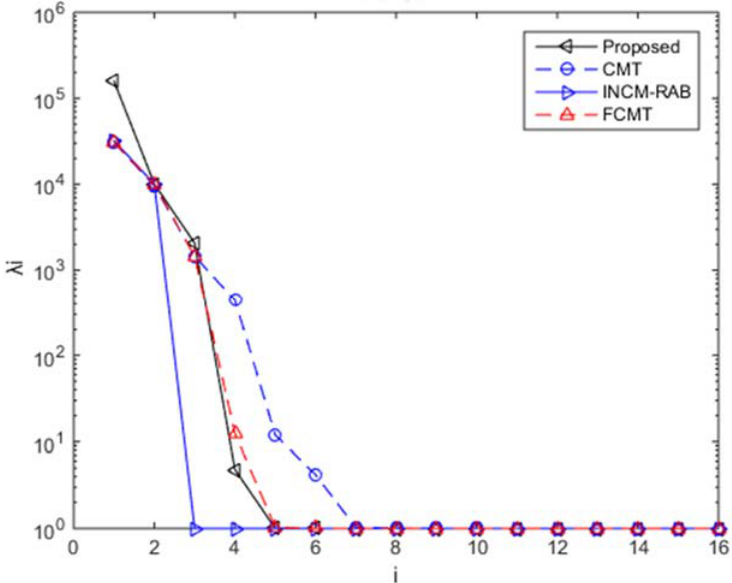
Figure 6. The descending trend of eigenvalues of covariance matrix.